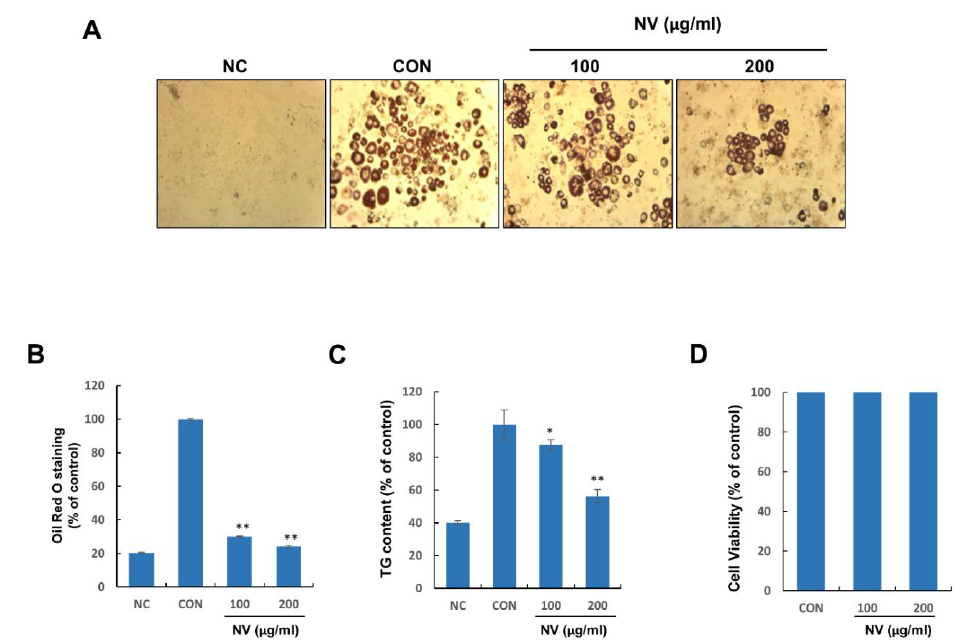
Figure 4. NV inhibits the differentiation and intracellular lipid accumulation of 3T3-L1 adipocytes without inducing cytotoxicity to preadipocytes. 3T3-L1 preadipocytes were treated with differentiation medium in the presence or absence of NV at 100 or 200 μg/mL for 8 days. ( A ) Differentiated adipocytes were photographed at a magnification of 40×. ( B ) The Oil Red O solution content was measured at an absorbance of 450 nm. ( C ) The intracellular TG content was assessed at an absorbance of 570 nm. ( D ) 3T3-L1 preadipocytes were treated with NV at the indicated concentrations, and cell viability was determined by the MTT assay using a spectrophotometer at a wavelength of 595 nm. Preadipocytes were used as the negative control (NC) and fully differentiated adipocytes were used as the positive control (CON). The NC and CON were treated with the same amount of DMSO instead of NV. All cell culture experiments are representative of three independent experiments. Data are presented as the mean ± standard error of the mean. Significant differences from the CON group are indicated by ** p < 0.01 and * p < 0.05. NV, Nidus vespae extract; TG,